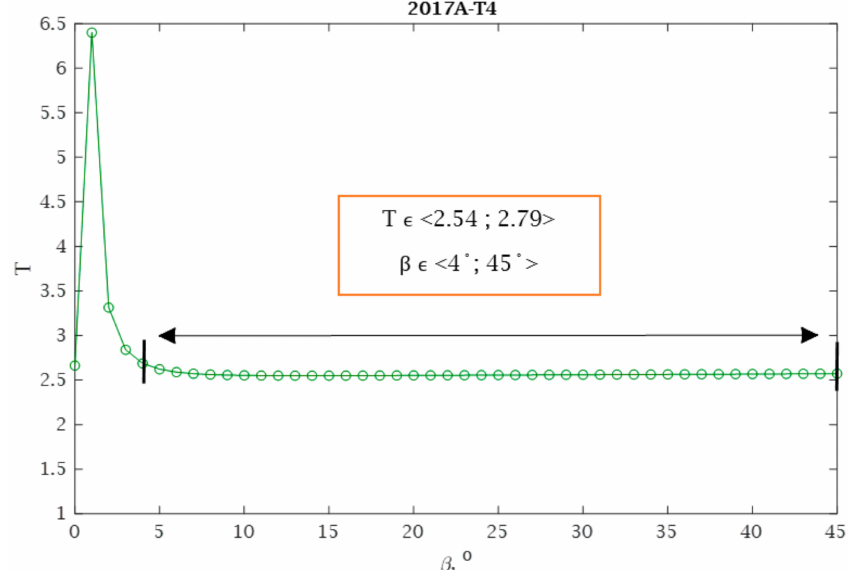
Figure 15. Correlation between T scatter value and β angle for aluminium alloy 2017A-T4.